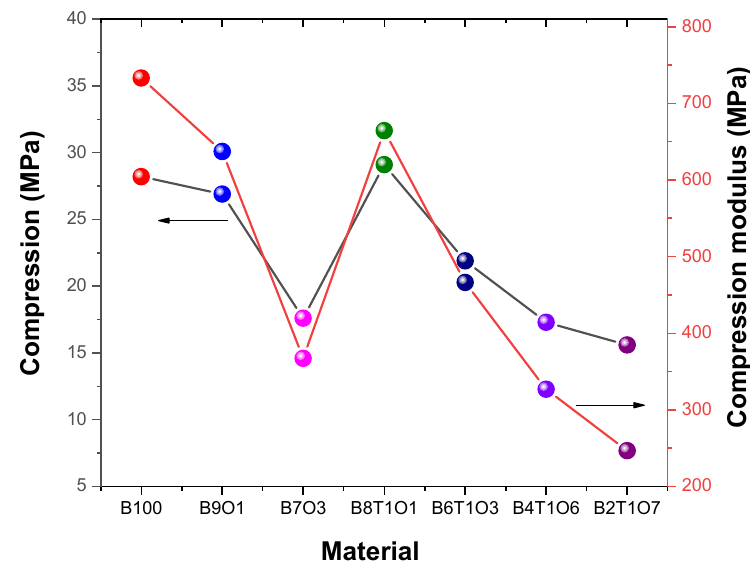
Figure 6. Compression and compression modulus of the 3D-printed specimens. The tensile strength of the B8T1O1 specimen was the highest at 14.5 MPa, and the B2T1O7 specimen was the lowest at 3.3 MPa. The Young’s modulus was the highest at 203.2 MPa in the B6T1O3 specimen(Figure 7). The measured values of the B6T1O3 and B8T1O1 specimens showed similar values, with a difference of about 8.1 MPa. Both specimens had low oligomer contents and contain TMPTMA. The B2T1O7 specimen showed the lowest value at 48.9 MPa. In the case of the tensile strength, it was found that the values changed according to the Bis-EMA and TMPTMA contained in the